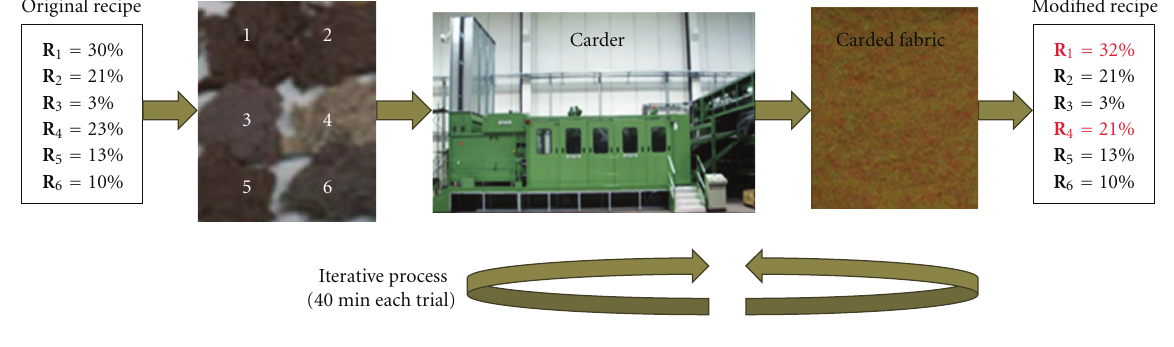
Figure 1: Trial and error technique. The production of a carded blend is performed in about 40 minutes. Typically 4-5 attempts are necessary to reach the optimal value for the recipe with a total time of about 200